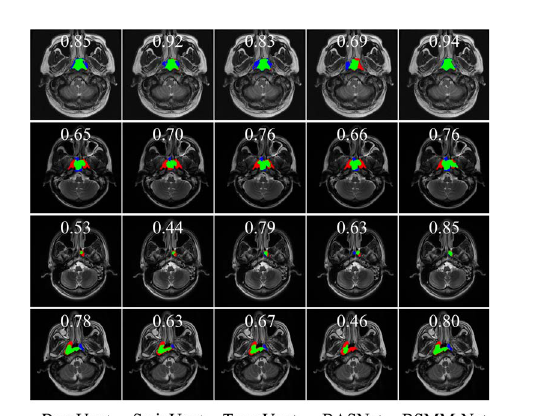
FIGURE6 Visualization of segmentation masks. The green regions are the NPC lesion regions correctly segmented by the models. The blue regions are the false positive regions erroneously divided into targets by models. The red regions are the false negative regions and the regions of NPC lesions missed by the models.